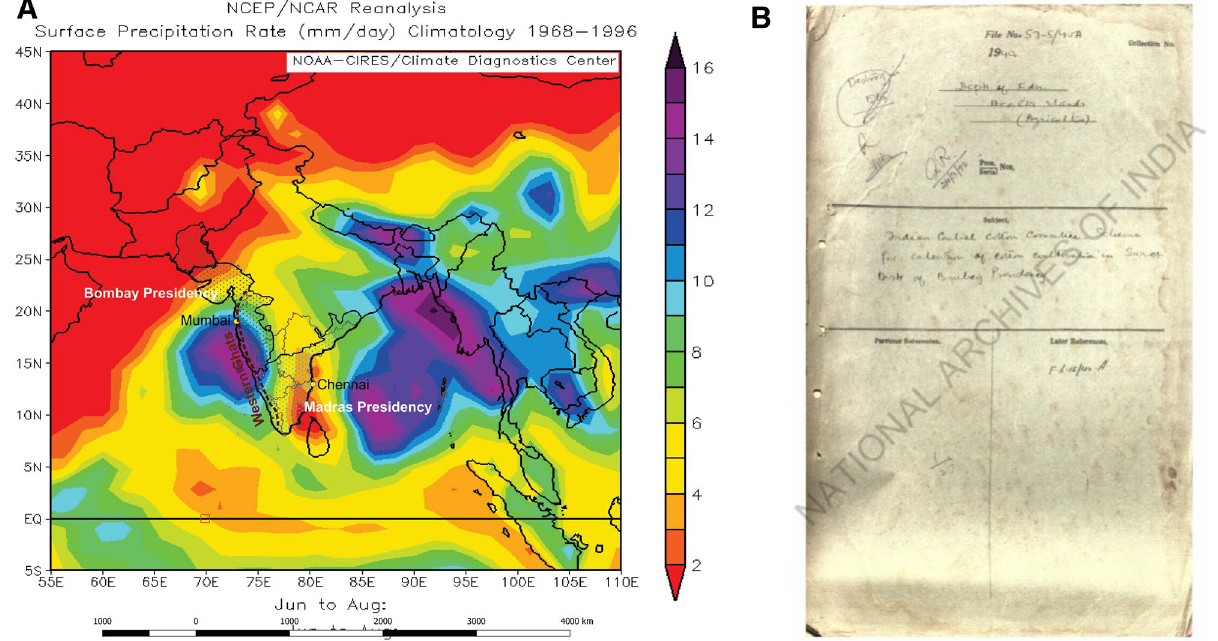
Figure 1. Study area and samples: ( A ) Our study area, the southern semi-arid regions of India (SIS), comprising of the Bombay and Madras Presidencies (administrative subdivisions of British colonial India), overlain on a twentieth century century precipitation climatology map of the Indian subcontinent 42